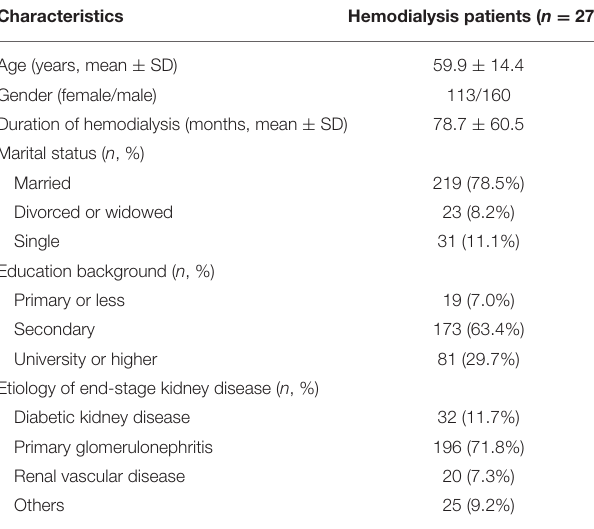
TABLE 1 | Baseline characteristics of the